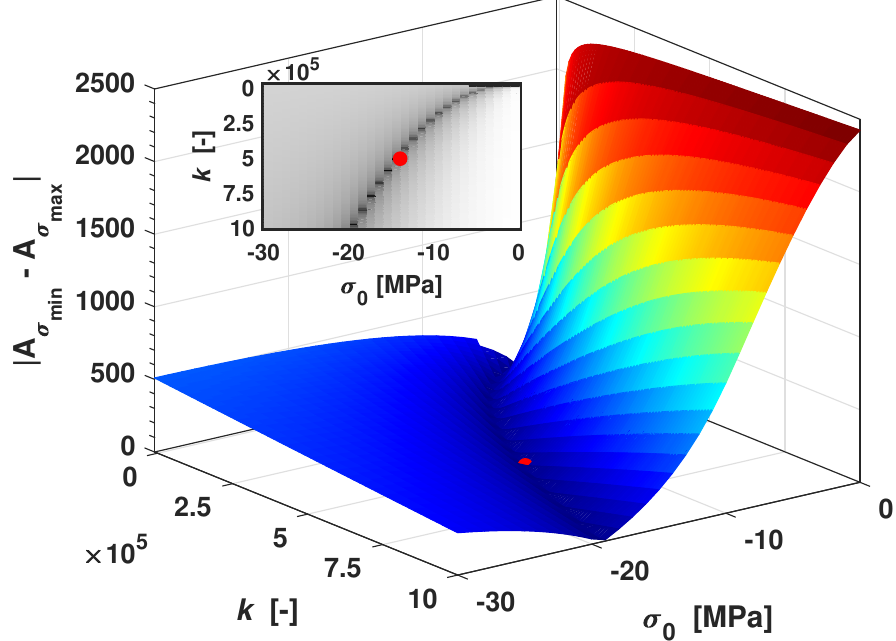
− A σ | surface of Equation (17) with respect to k and σ Figure 10. | A σ max min shows the top-view of the surface with a gray logarithmic color-map scale, while the red dot indicates the minimum in the considered parameters range.